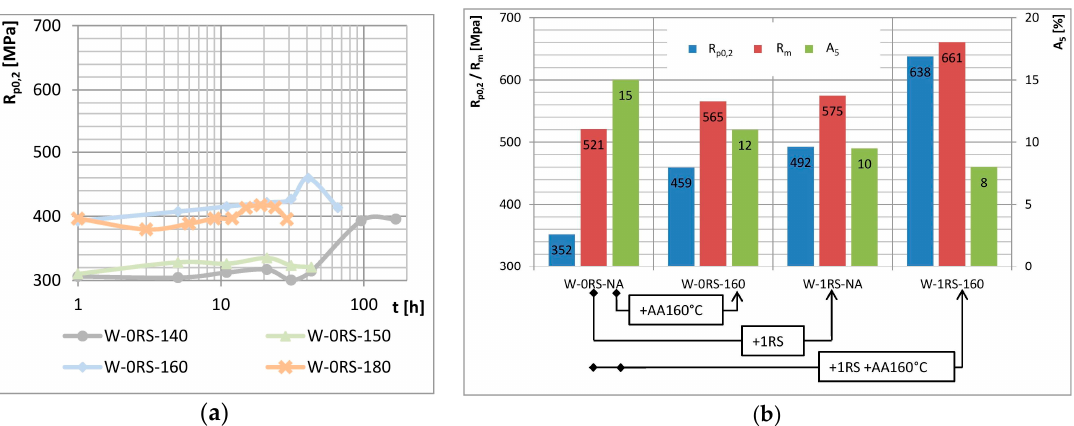
Figure 6. ( a ) Yield strength vs. time of AA for the condition with no deformation (0RS); ( b ) Mechanical properties of material of four selected conditions.